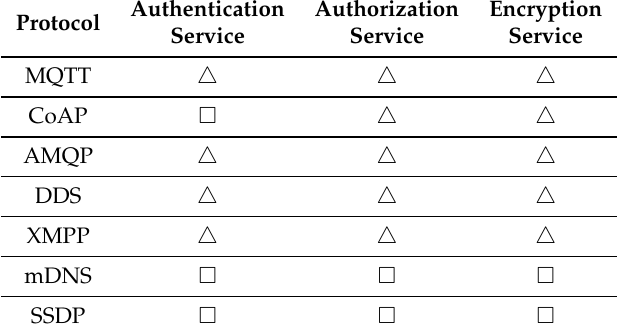
Table 3. Summary of the major security risks affecting the services of the application layer protocols analyzed in this paper. The squares refer to the lack of the security service, while the triangles to its incorrect configuration.